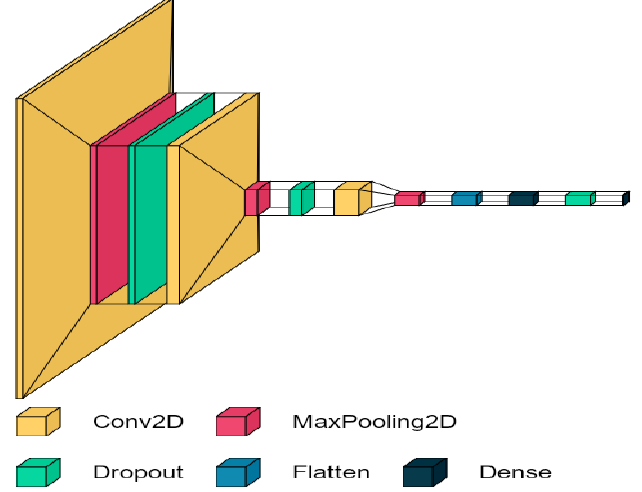
Figure 3. Custom architecture of the deep learning classifier.